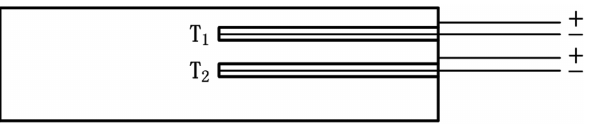
Figure 2: Diagram of temperature measure method on the copper